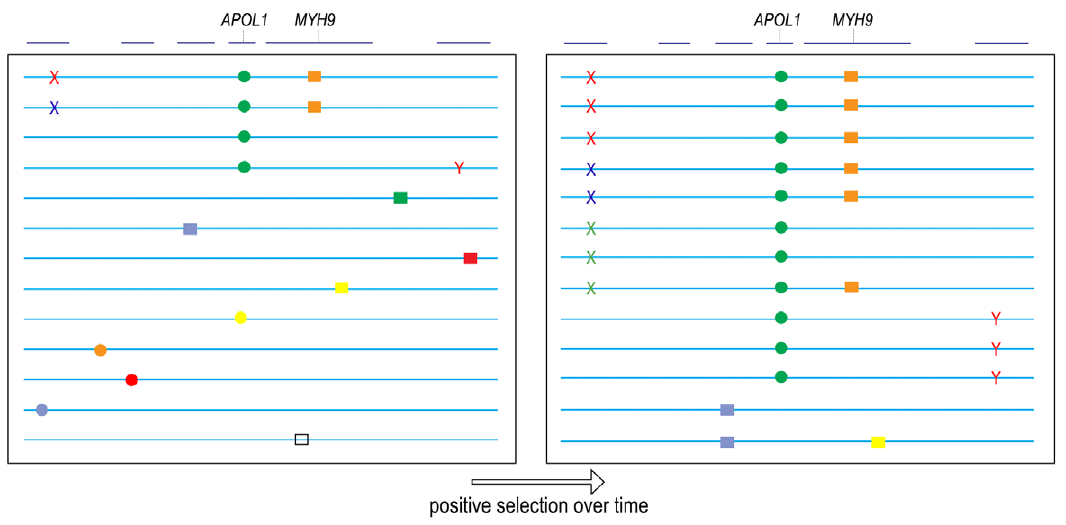
Figure 4. Model of ‘‘Genetic Hitchhiking’’ at the MYH9 / APOL1 locus. All genes at the locus (blue lines, top) are not depicted. The G1 and G2 APOL1 polymorphisms (green circle) undergo positive selection over time due to increased resistance against Trypanosoma, eventually reaching high allele frequency. In the process, other nearby polymorphisms ‘‘hitchhike’’ along with G1 and G2, including intronic polymorphisms in MYH9 (orange box), and hypothesized ‘‘glomerulosclerosis polymorphisms’’ in linked disease genes that have not been identified. The number of such ‘‘glomerulosclerosis polymorphisms’’ and the number of genes involved (1 or several) is not known. For the purposes of this cartoon we depict three hitchhiking polymorphisms (Xs of different colors) in a disease gene on one side of APOL1 , and 1 polymorphism (Y) in a second disease gene on the other side of APOL1 . We hypothesize that each individual ‘‘glomerulosclerosis polymorphism’’ is present at low frequency and has escaped statistical significance within the cohorts that have been examined, but in aggregate, multiple ‘‘glomerulosclerosis polymorphisms’’ that hitchhiked along with APOL1 may account fully for disease. Possible methods of identifying such glomerulosclerosis polymorphisms are proposed in the Discussion. This hypothesis of multiple, rare polymorphisms that hitchhike along with G1 and G2 could explain why APOL1 correlates highly with glomerulosclerosis and yet only , 5% of G1/G2 homozygous individuals develop glomerulosclerosis (those 5% of G1/G2 persons who are also homozygous for the hitchhiking ‘‘glomerulosclerosis polymorphisms’’). Lastly, we make no assumptions about the evolution of these causal ‘‘glomerulosclerosis polymorphisms,’’ which may have been present in cis to G1/G2 before a selective sweep (red and blue X, red Y), or may have arisen during or late in the process of positive selection for G1/G2 (green X). Two recombination events are depicted, and while neither is informative, recombination breakpoints of uncommon HIVAN or FSGS patients who do not have 2 alleles of G1/G2 may be highly informative (see Discussion).